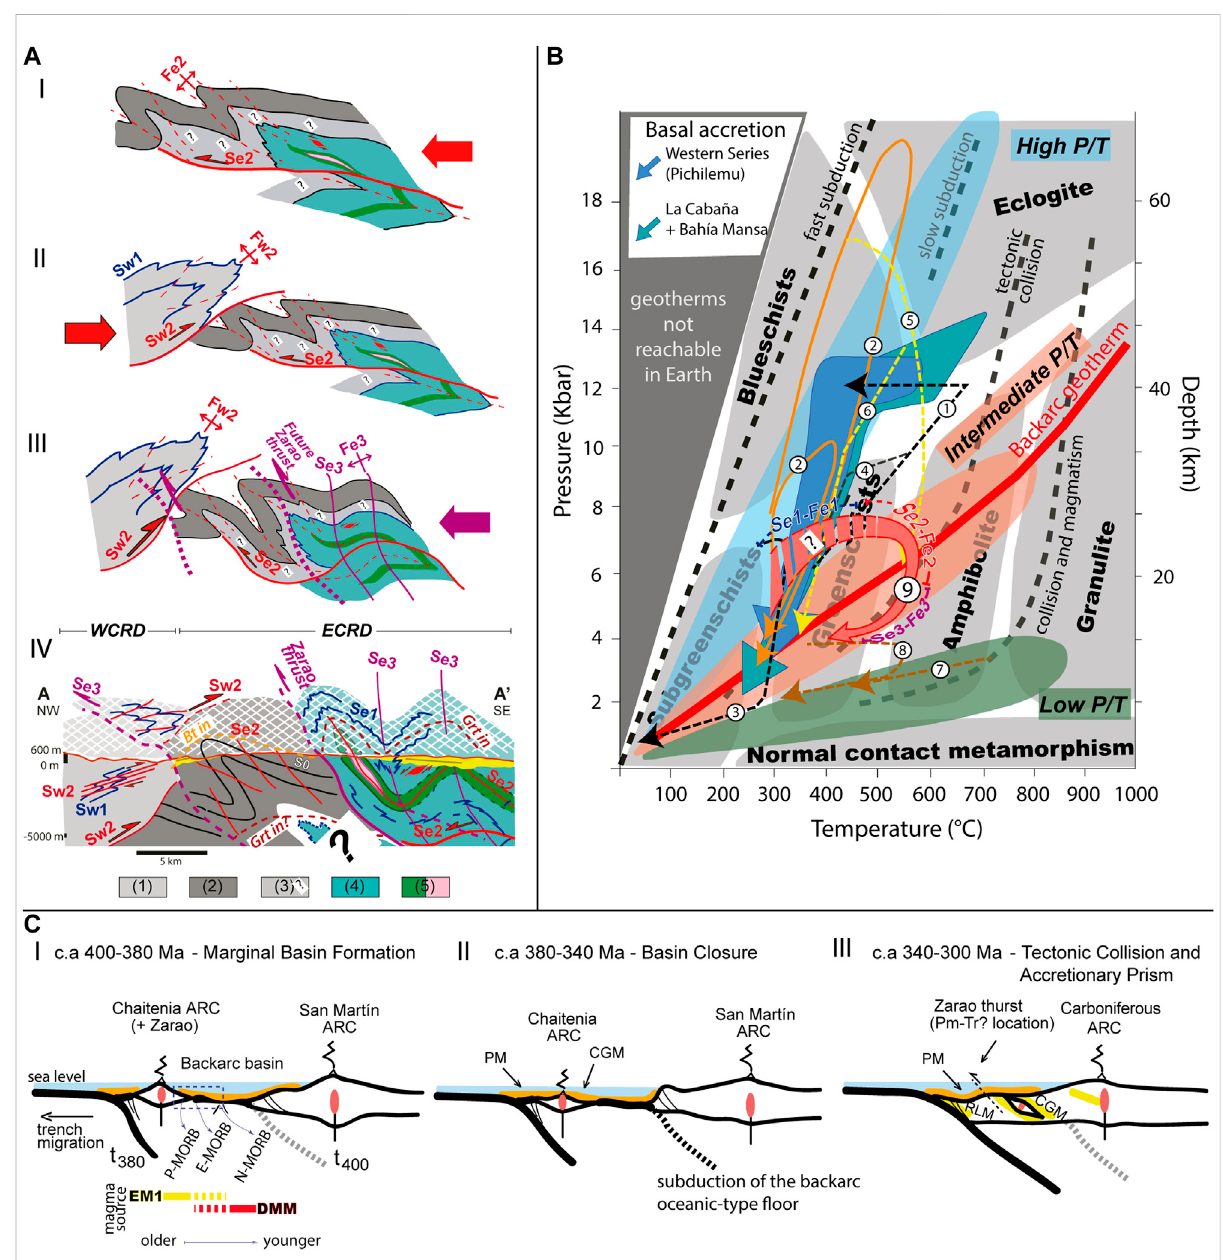
FIGURE 12 Metamorphism, and structural and tectonic analysis. (A) Schematic sketch for the development of the structures presented in this study. (I) Se2 – Fe2 ductile structures, (II) Sw2 – Fw2 ductile structures, (III) Se3 – Fe3 ductile structures, and (IV) fi nal stage. (1) Río Llico Micaschists, (2) Pinuno Metasandstones, (3) unknown unit, (4) Cajonmo Garnet Micaschists, and (5) Zarao Metavolcanic Rocks. (B) Compilation of P – T paths of the Chilean metamorphic basement above the metamorphic facies with geologic geotherm processes modi fi ed from the work of Bucher and Grapes (2011). The metamorphic fi eld gradient of the metamorphic series and the backarc geotherm were extracted from the work of Oh (2021) and Hyndman(2019),respectively.TheP – Tpathsareextractedfromtheworkof(1)Willneretal.(2004),(2)Plissartetal.(2021),(3)Willneretal.(2001),(4) Hyppolito et al. (2014), (5) Cruz-Martínez et al. (2012), (6) Kato and Godoy (2008), (7) Willner (2005), (8) Hyppolito et al. (2015), and (9) this work. (C) Schematic cross section showing the margin evolution of the Devonian – Carboniferous North Patagonian segment. (I) ca. 400 – 380 Ma: marginal backarc basin formation, (II) ca. 380 – 340 Ma: basin closure, and (III) ca. 340 – 300 Ma: tectonic collision and accretionary prism development. PM: Pinuno Metasandstones, CGM: Cajonmo Garnet Micaschits, and RLM: Río Llico